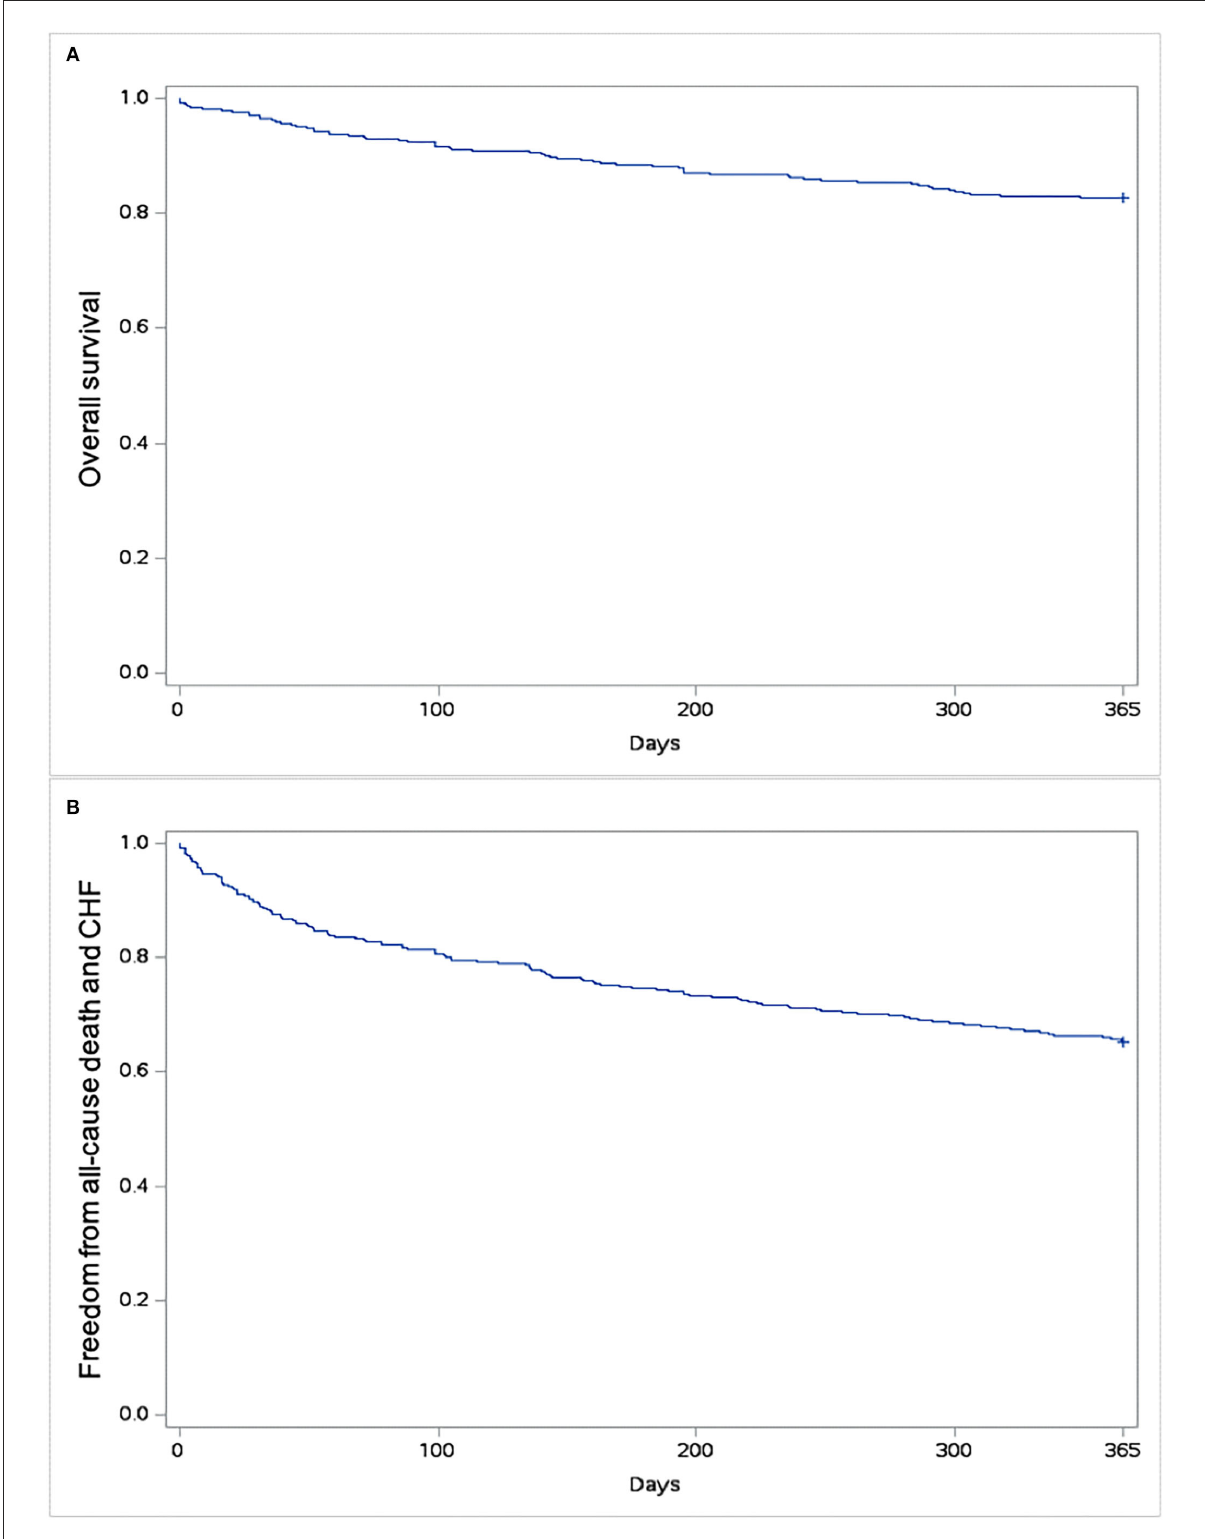
FIGURE3 Kaplan–Meyer estimates of survival (A) and freedom from all-cause mortality and/or rehospitalization due to congestive heart failure (CHF) (B)